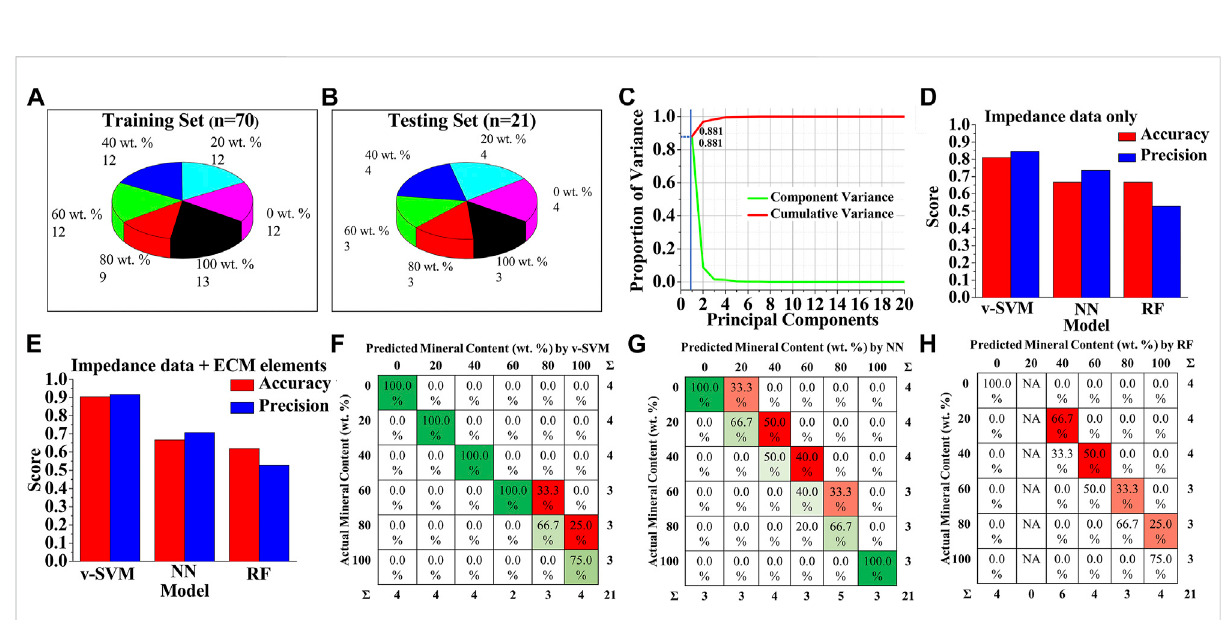
FIGURE 4 MachineLearning-baseddetectionofbonemineralcontent (A,B) Datasetswithdifferentbonemineralcontents,usedfortrainingandtestingof machine learning models (C) Representative PCA scree plot showing the number of components used (blue line) along with proportion of variance explained. Classi fi cation performance of the three types of discrimination models when (D) only impedance data were used for training and testing, and (E) bothimpedance data andequivalentcircuit- fi ttedelement data wereused for training and testing (F – H) Confusion matrix for (F) v-SVM (G) Neural Network, and (H) Random Forest algorithms for bone mineral content classi fi cation when both impedance data and equivalent circuit- fi tted element data were used for training and